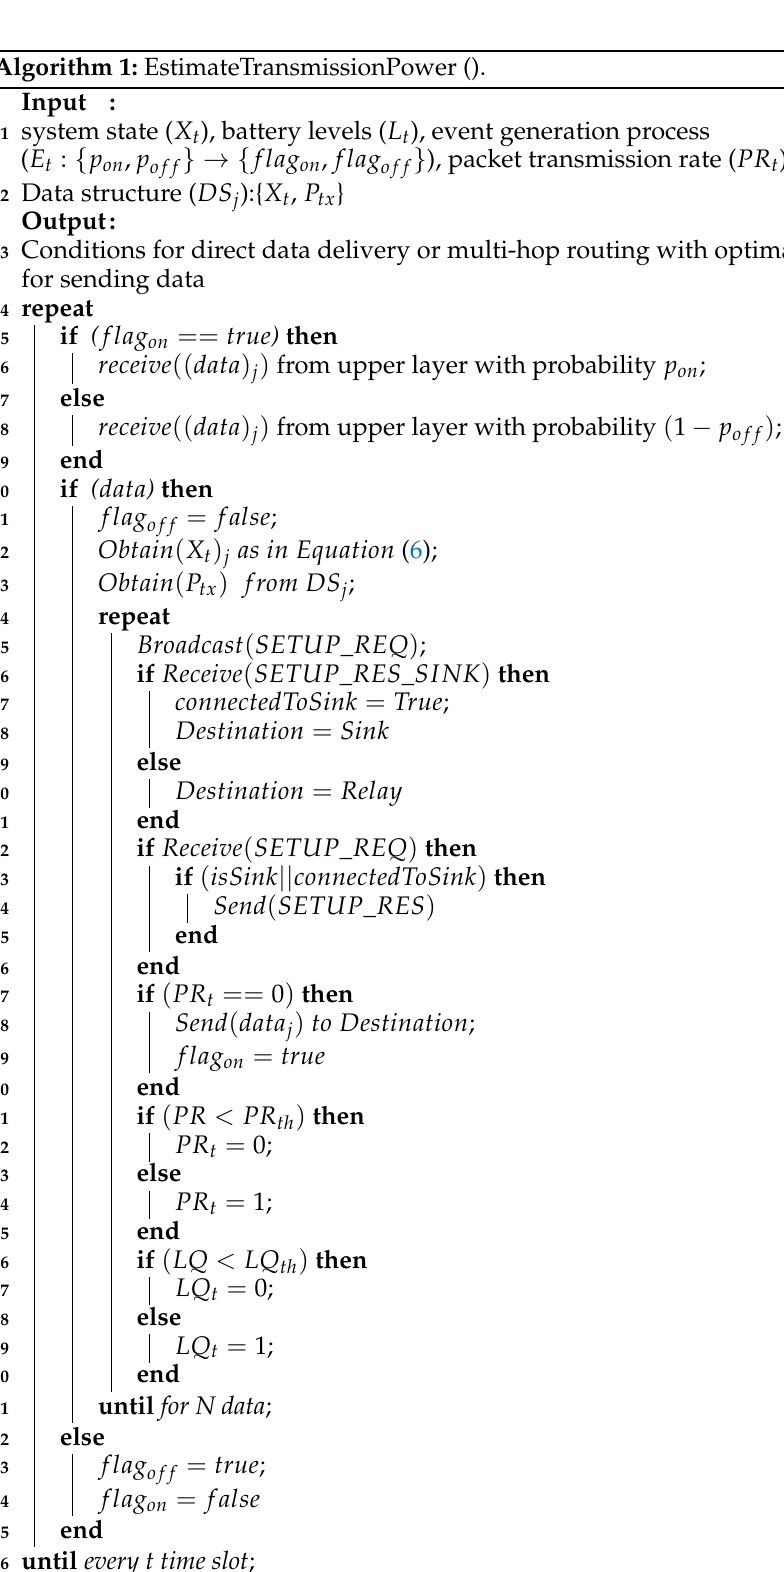
Algorithm 1: EstimateTransmissionPower